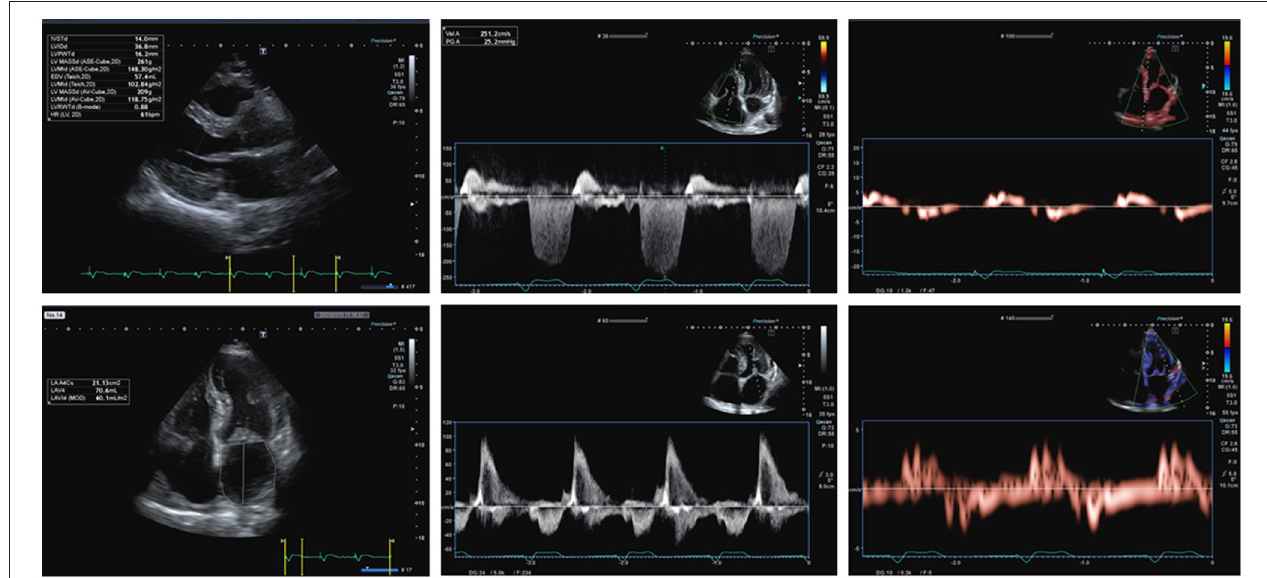
FIGURE 1 | A 71-year-old male patient complained dyspnea on mild effort, fatigue, and lower limb edemas, 7 years before he was diagnosed with AL amyloidosis. More recently, he was subjected to implantation of bicameral pacemaker and after that he presented persistent atrial fibrillation. ECG showed atrial fibrillation with a ventricular paced rhythm (mean ventricular rate: 75 bpm) and low-voltage QRS complexes in limb leads. So, according to the proposed Heart Failure Association (HFA) algorithm, the pretest assessment resulted suggestive of heart failure with preserved ejection fraction (HFpEF). 2D transthoracic echocardiography (TTE) apical 4-chamber view showed significant thickening of the both ventricles (ventricular septum wall thickness = 14mm, LV posterior wall thickness = 16mm, right wall thickness (RWT) = 0.83, left ventricle mass indexed (LVMi) = 150 g/m 2 ), biatrial enlargement [left atrium volume index (LAVI) = 40 mL/m 2 ], and thickening of atrioventricular valves. 2D TTE showed preserved systolic function of left ventricle assessed by biplane Simpson’s method [left ventricular ejection fraction (LVEF) 55%]. 2D TTE apical 4-chamber view with pulsed wave Doppler showed peak E velocity equal to 93 cm/s. 2D TTE tissue Doppler imaging (TDI) showed reduced septal mitral annular peak early diastolic velocity e’ (3.4 cm/s) and reduced lateral mitral annular peak early diastolic velocity e’ (3.6 cm/s), with a E/e’ ratio equal to 26.6. Color Doppler assessment showed mild tricuspid regurgitation with TRV equal to 2.5 m/s. Blood tests showed NT-proBNP equals to 3,251 pg/mL. The Echocardiographic and Natriuretic Peptide Score (Step 2 of the proposed HFA Algorithm) is equal to 6: in the functional domain, the patient scores 2 points (major criterion: septal e’ < 7 cm/s, lateral e’ < 10 cm/s, average E/e’ ≥ 15), in the morphological domain, he scores 2 points (major criterion: LVMI ≥ 149 g/m 2 in males